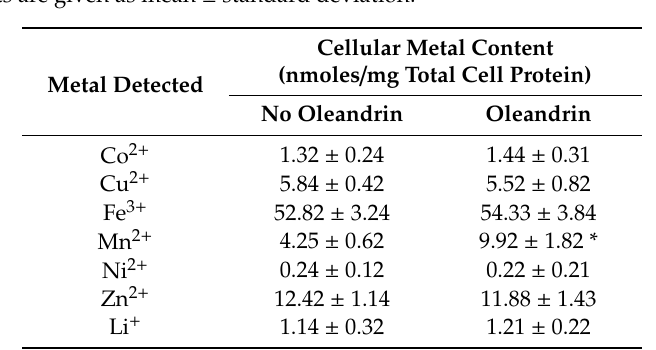
Table 1. E ff ect of oleandrin on metal content of yeast cells. Exponentially growing wild type cells were shifted to MMe (OD 600 = 0.5) in the presence of oleandrin (100 ng / mL). Cells were grown with agitation